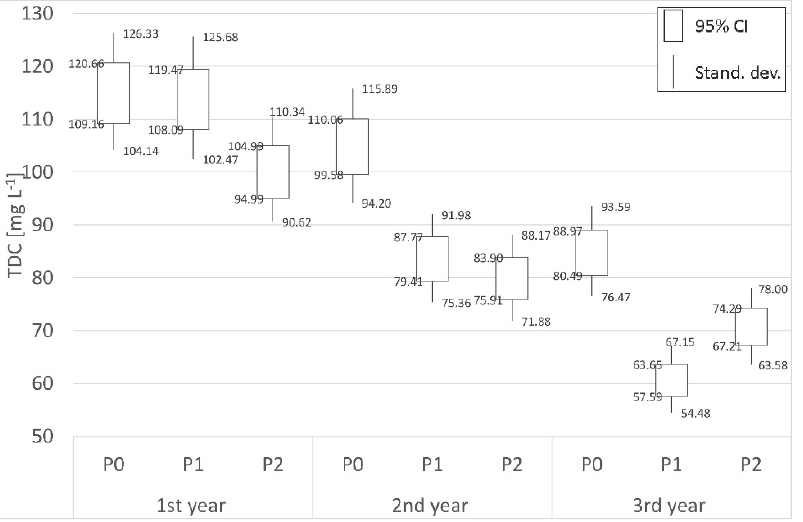
Figure 2. The concentrations of TDC in groundwater under peatland soils ( □− 95% confidence interval, │ - standard deviation).